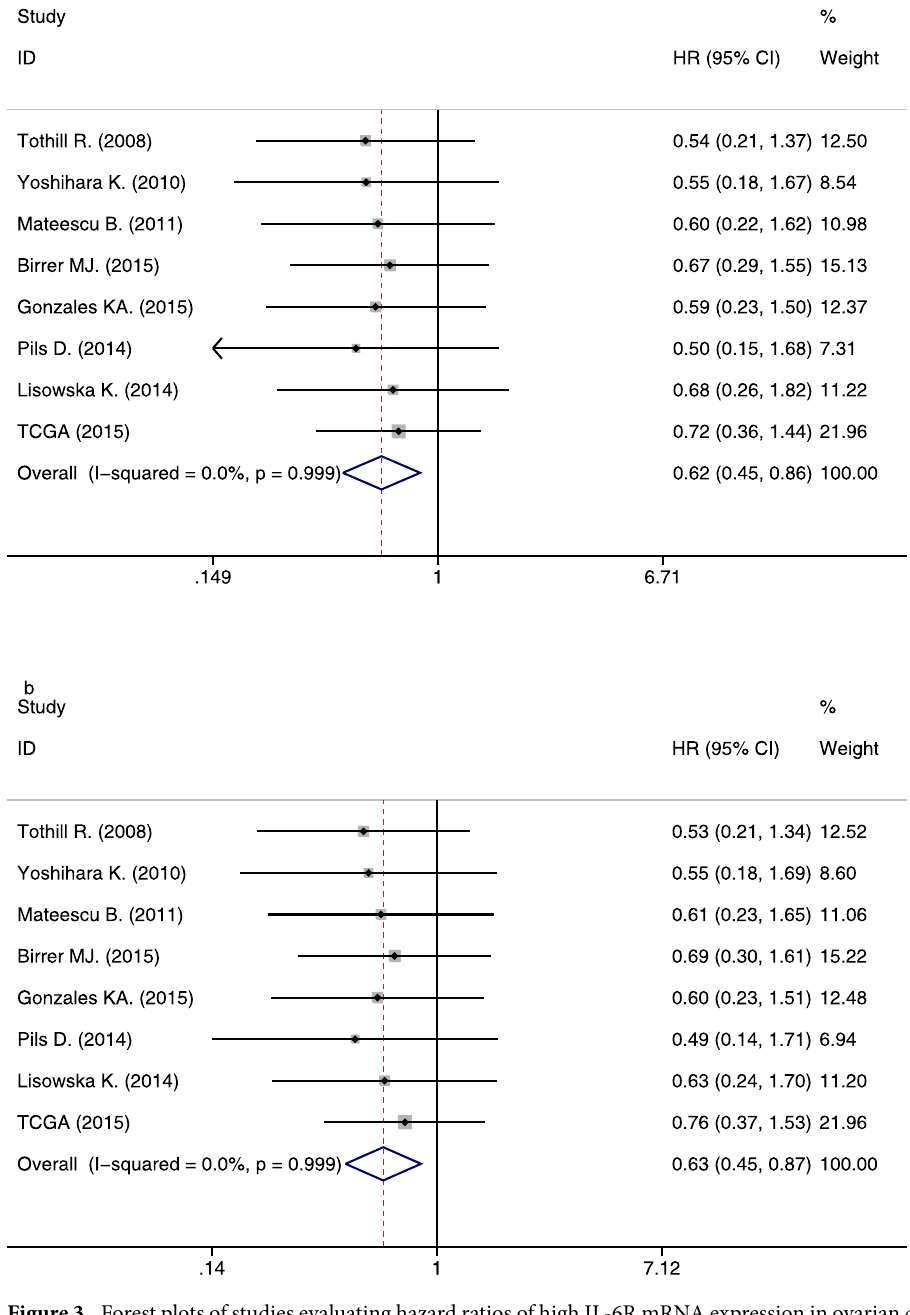
Figure 3. Forest plots of studies evaluating hazard ratios of high IL-6R mRNA expression in ovarian cancers for OS. ( a ) univariate analysis. ( b ) multivariate